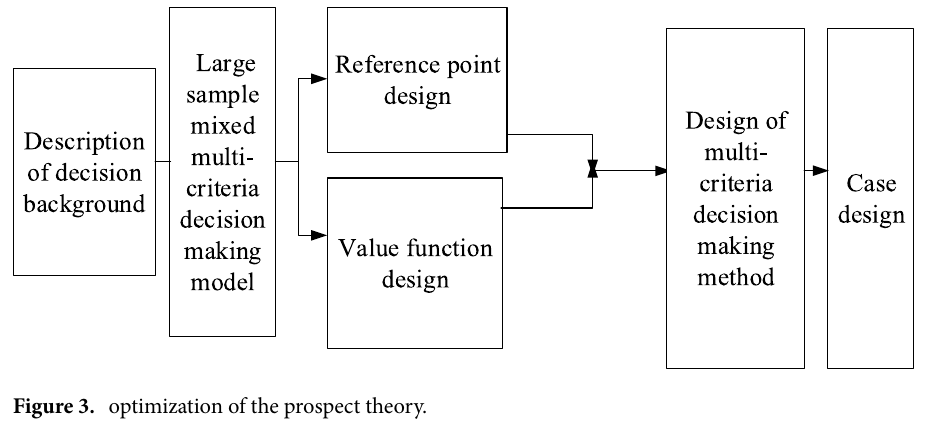
Figure 3. optimization of the prospect